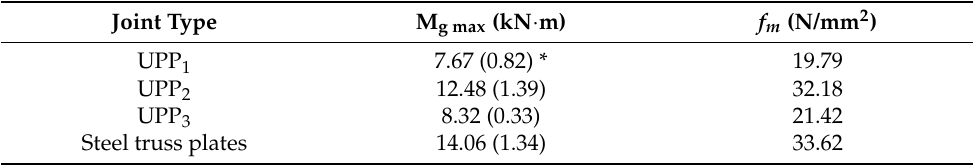
Table 5. Evaluation of the mechanical properties of the manufactured truss models.